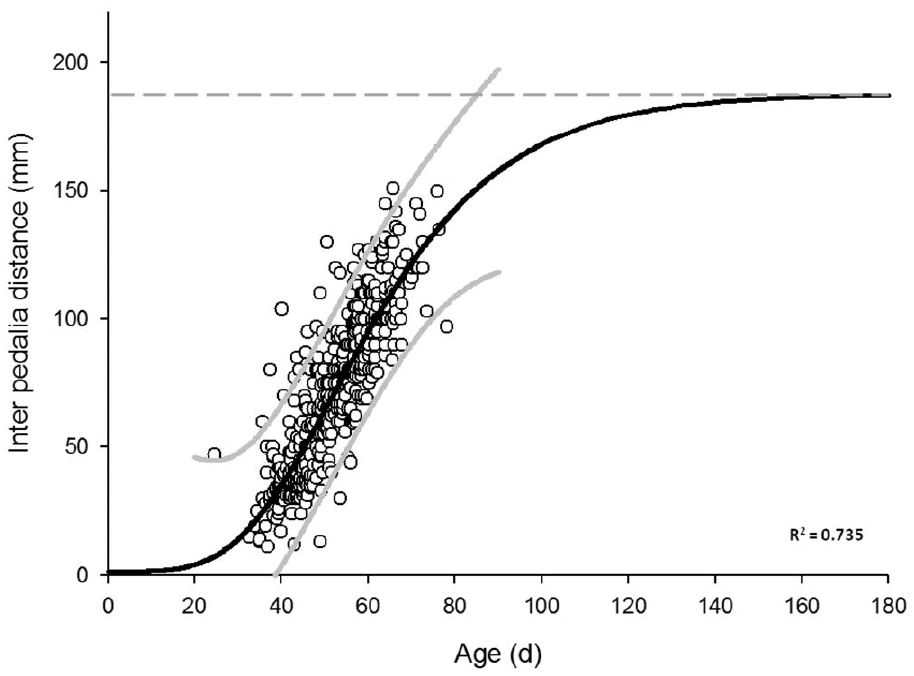
Figure 7. Gompertz growth curve for significant, positive relationship between age and IPD of Chironexfleckeri medusae. Growth curve shows medusae size (IPD) in mm at age in d with 95% prediction limits (grey solid line).